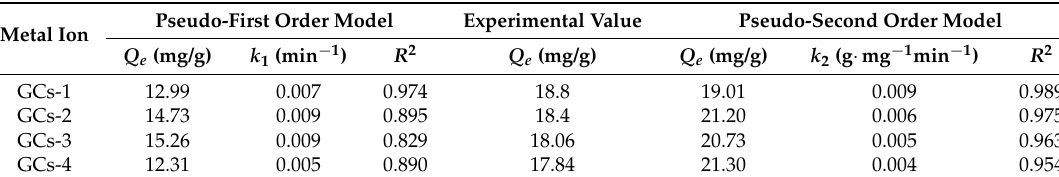
Table 4. Constants and correlation coefficient of pseudo-first order and pseudo-second order kinetics of copper adsorption.